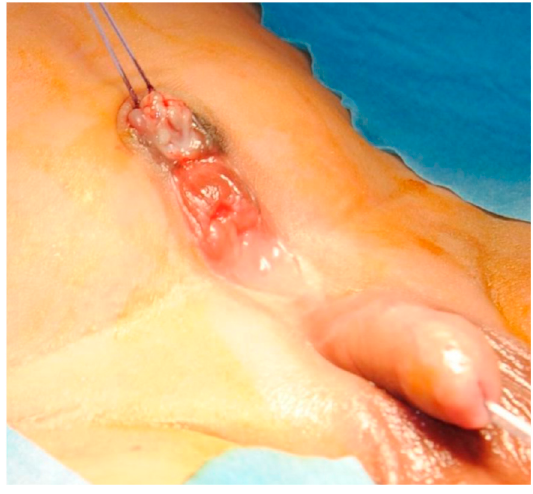
Figure 1. Lower abdomen with exstrophic mucosal plate and normal external genitalia.